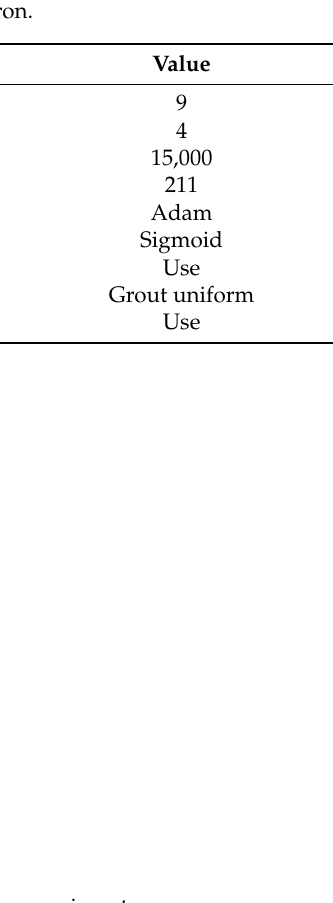
Figure 9. The uniform data sampling method used in the experiment.